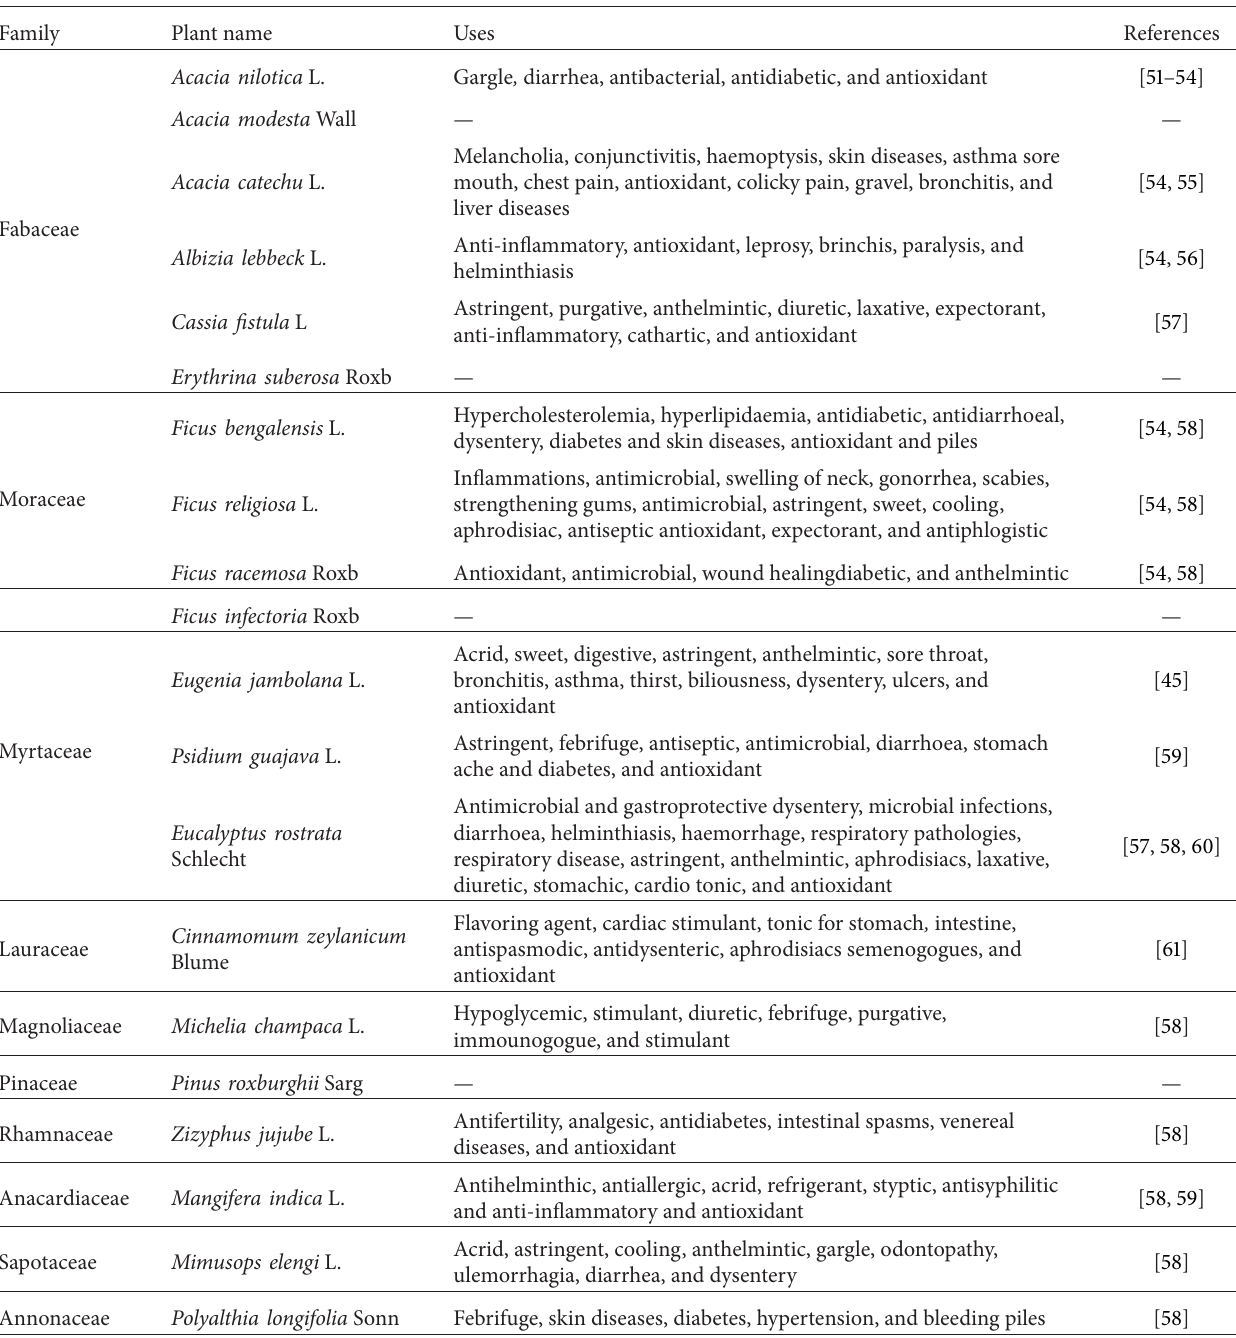
Table 2: Medicinal uses of stem bark of the selected medicinal